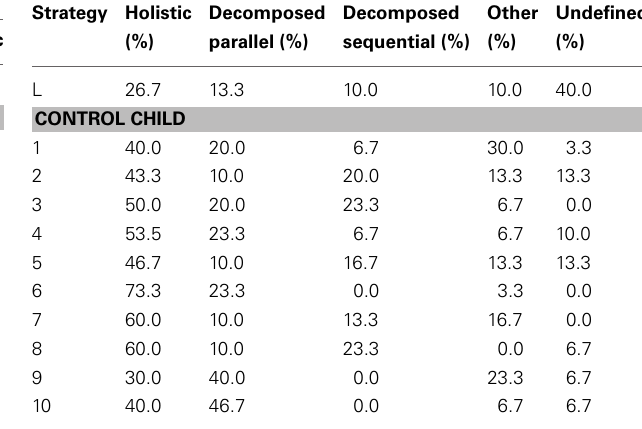
Table A2 | Overview of the individual logarithmic and linear fit measures of the child with dyscalculia and the control children on the non-symbolic 0–100 and symbolic 0–100 and 0–1000 number line tasks.